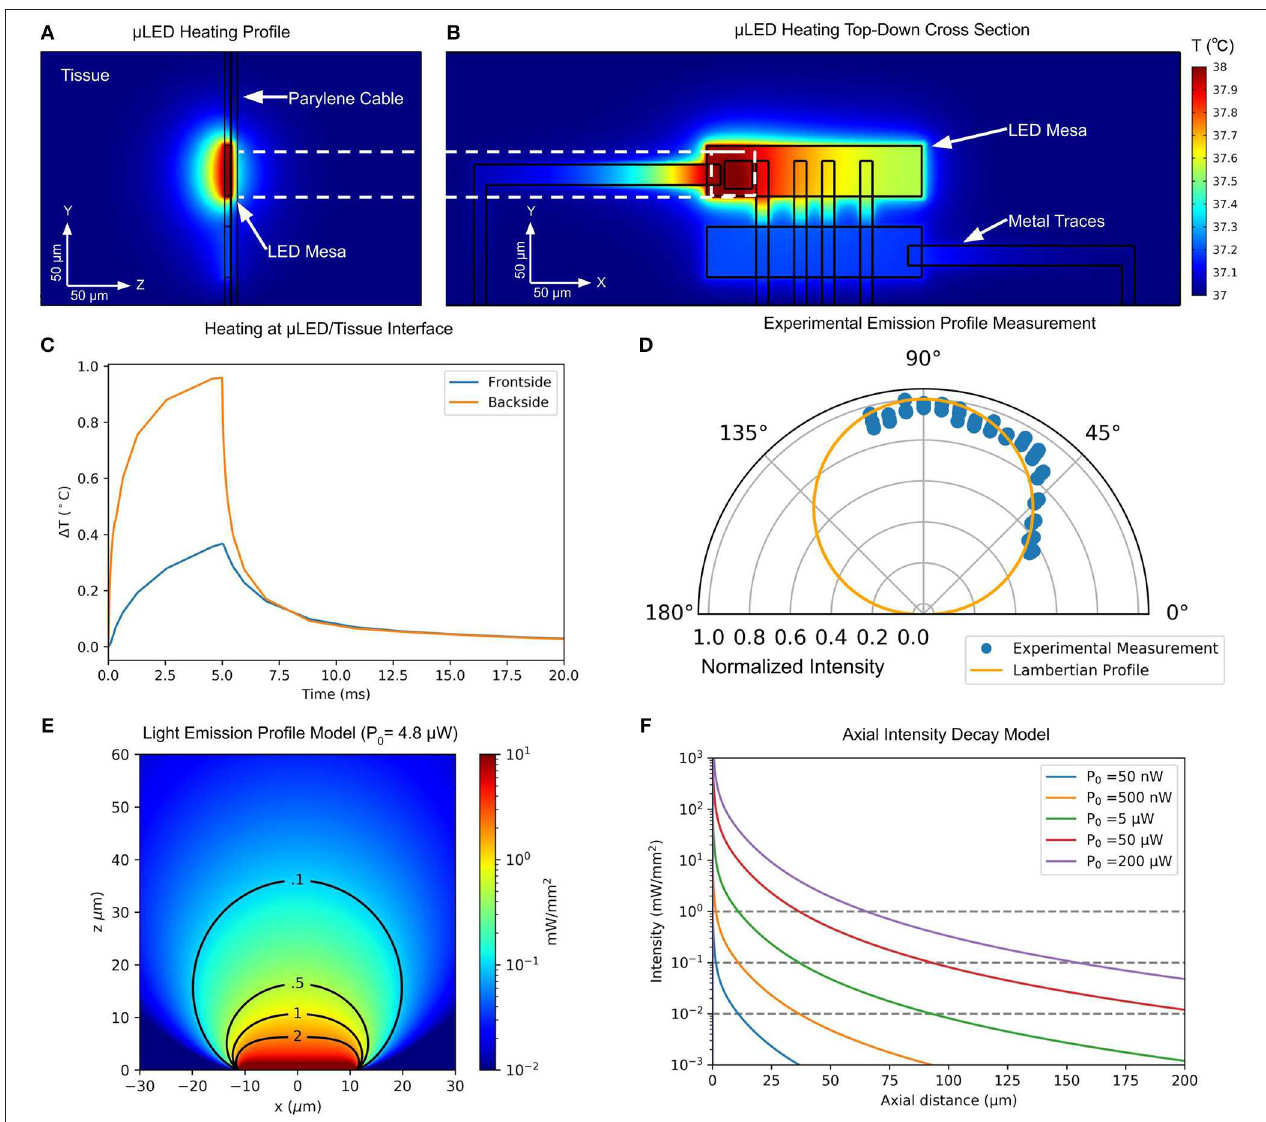
FIGURE 5 | (A) Profile of simulated tissue heating using Pennes bio-heat model at 90 µ A of µ LED drive current. Due to the difference in thermal conductivity between GaN and Parylene C, front- and backside of the probe experience different amounts of tissue heating. (B) Top-down cross section of heat spread in µ LED device structure at 90 µ A of µ LED drive current. Thermal conduction in GaN mesa and along metal traces can be observed. (C) Tissue heating plot at front- and backside probe/tissue interfaces for 5-ms, 90- µ A pulse. (D) Experimental measurement of directional µ LED intensity profile and comparison to ideal Lambertian source. (E) Analytical model of light intensity in tissue from a Lambertian source with 4.8 µ W of optical power. (F) Analytical model of axial intensity profile in tissue for various optical